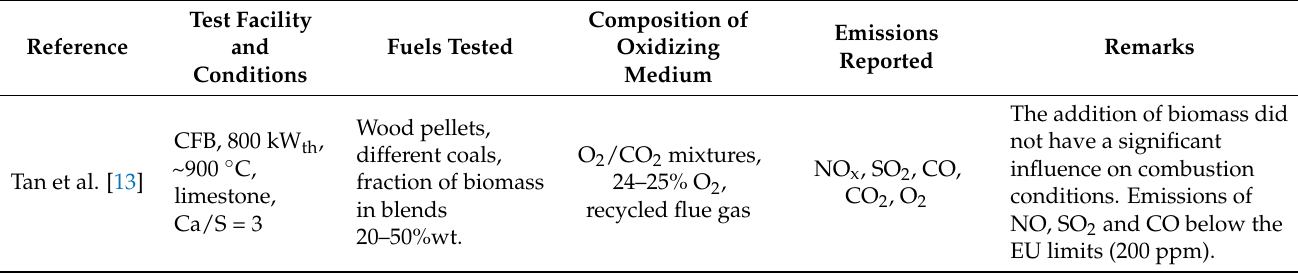
Table 1. A summary of the literature